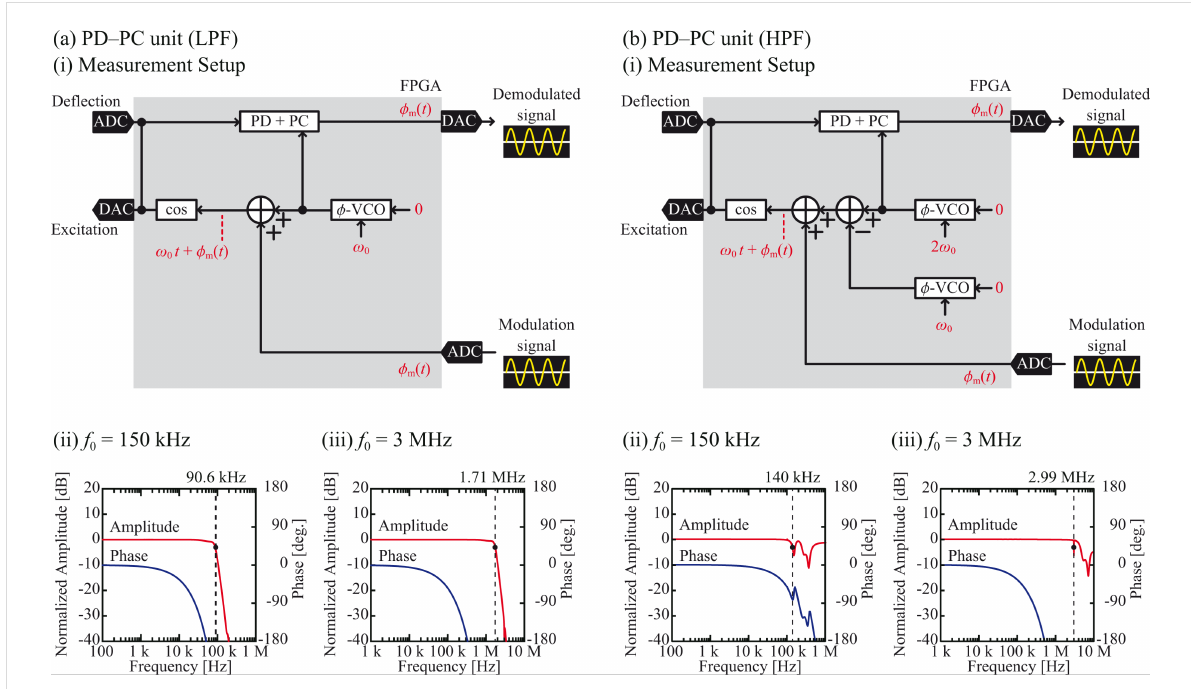
Figure 4: Performance of the implemented PD–PC units with (a) a LPF and (b) a HPF. (i) Block diagram of the setup. Frequency responses of the PD–PC units with (ii) f 0 = 150 kHz and (iii) f 0 = 3 MHz.